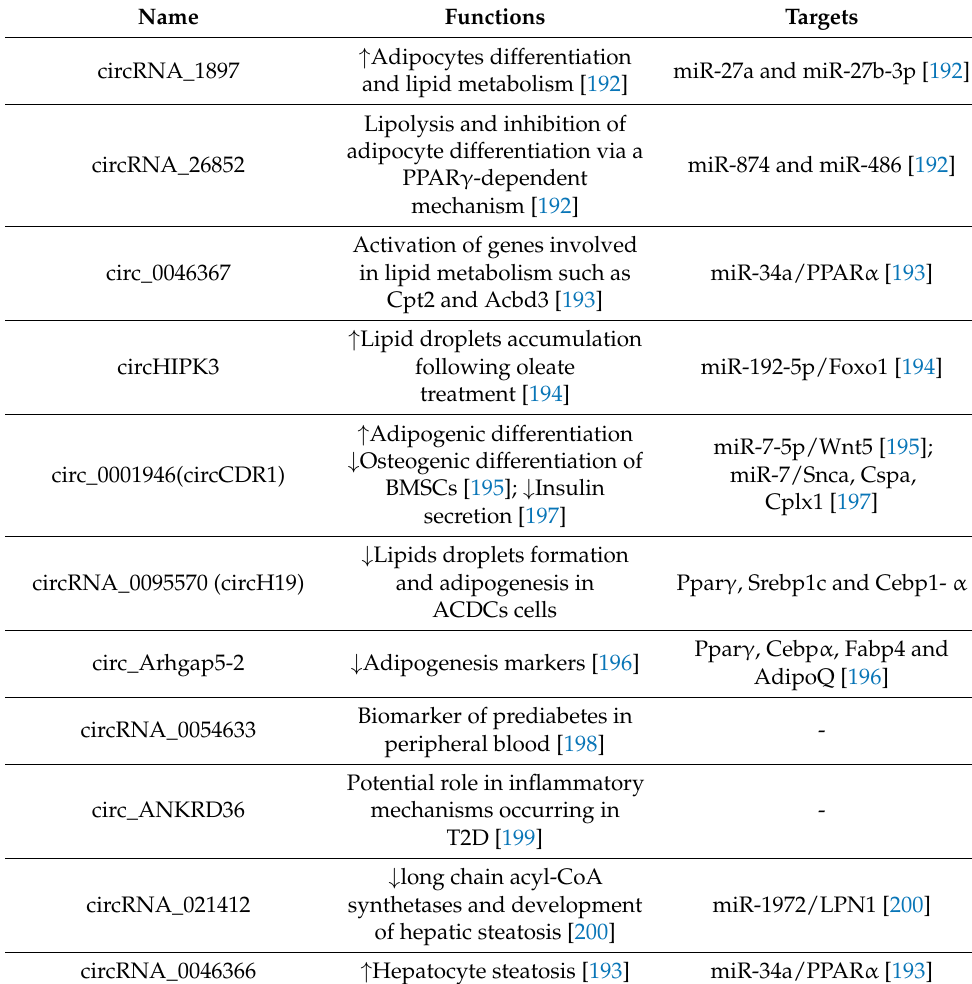
Table 3. Summary of the cited circRNAs involved in metabolic diseases and their mechanisms of